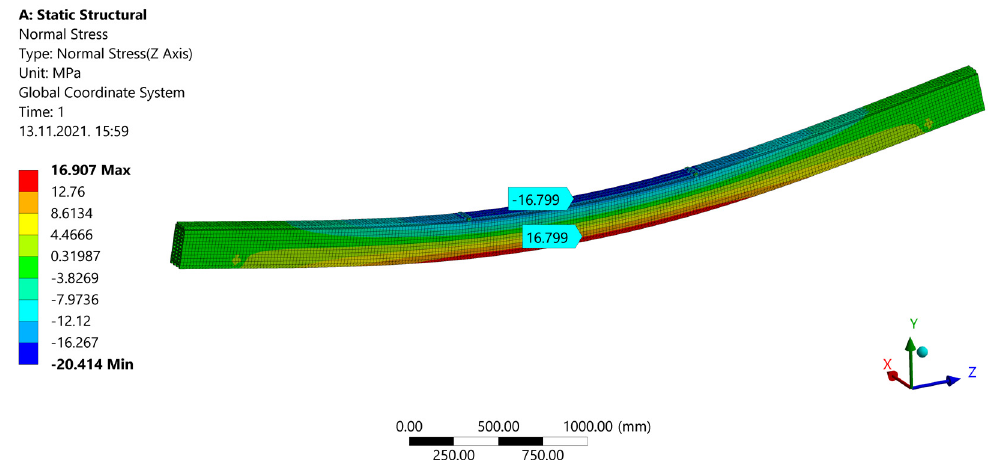
Figure 30. Deflection of the beam.